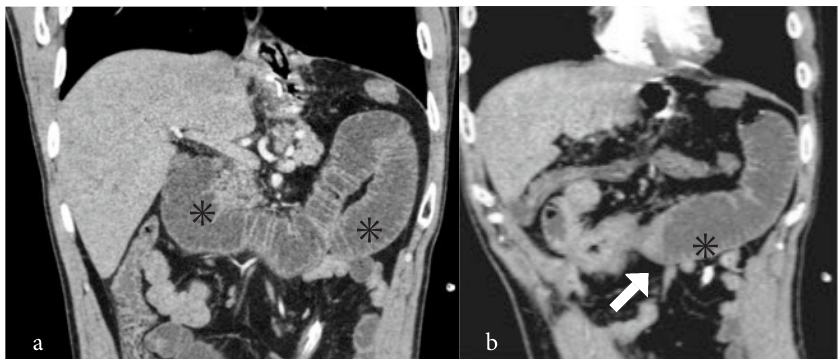
Fig. 3. 3a and 3b: Coronal multiplanar reconstructions showing distended duodeno-jejunal afferent limb (*) with transition point